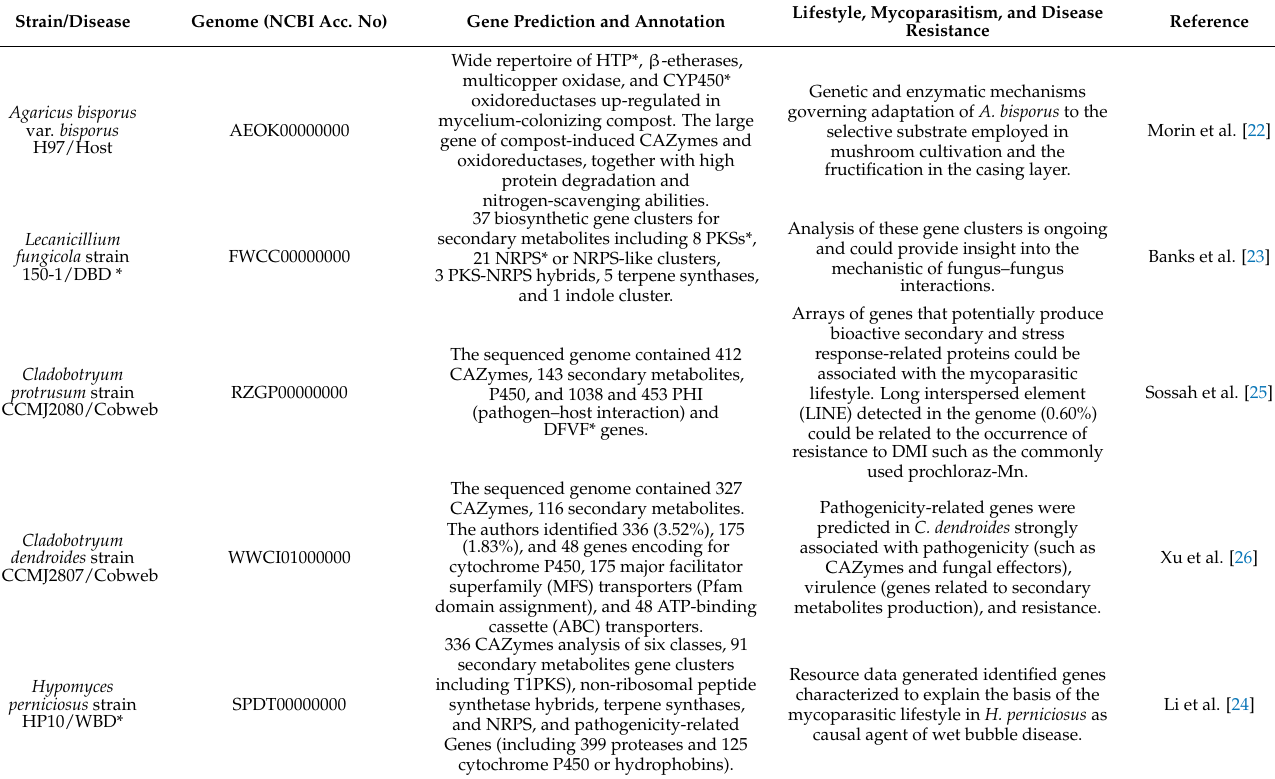
Table 2. Genome features of host strain and mycoparasites were recently released as a source of information for breed- ing